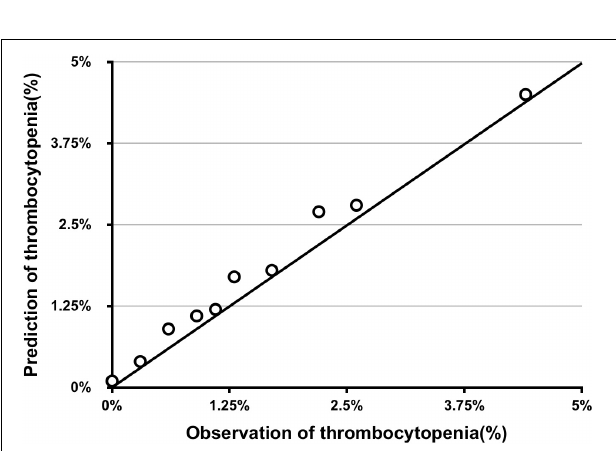
FIGURE 4 | Calibration plot of predicted vs. observed thrombocytopenia of risk score in the validation